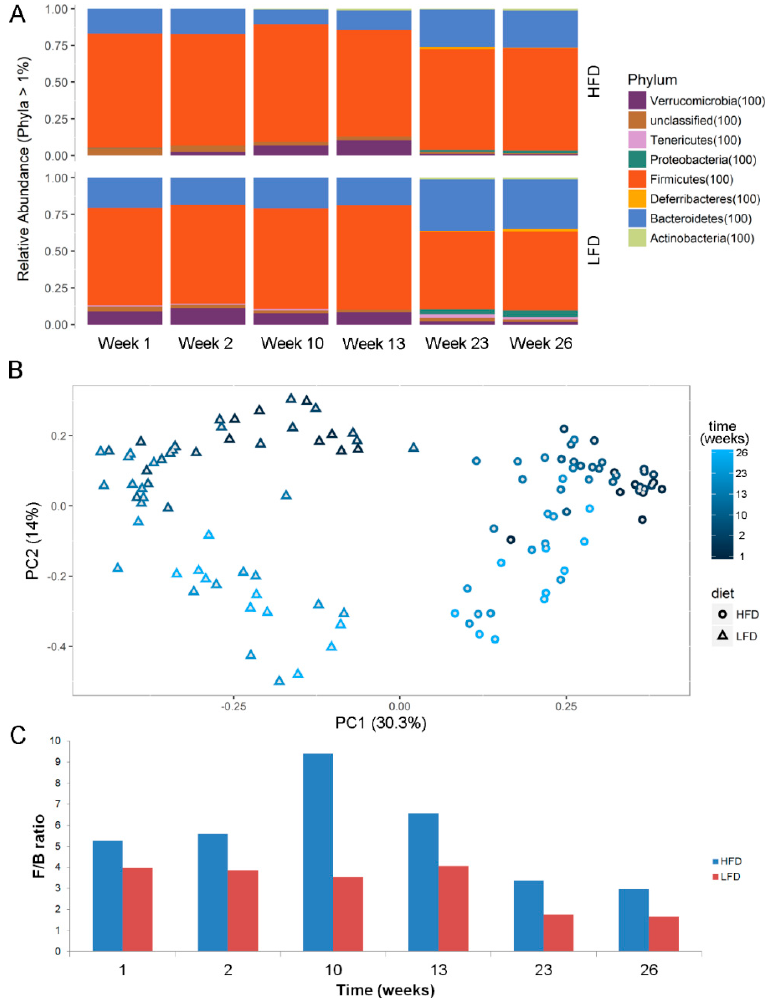
Figure 6. ( A ) Phyla abundance and ( B ) Unsupervised ordination using Bray–Curtis dissimilarity-based principal coordinates plot showing clusters of diets (PC1) and time (PC2). ( C ) ratios of relative abundance of firmicutes and bacteriodetes (F/B ratio) at different time ‐ points. Abbreviations: LFD, low ‐ fat diet; HFD, High ‐ fat diet.